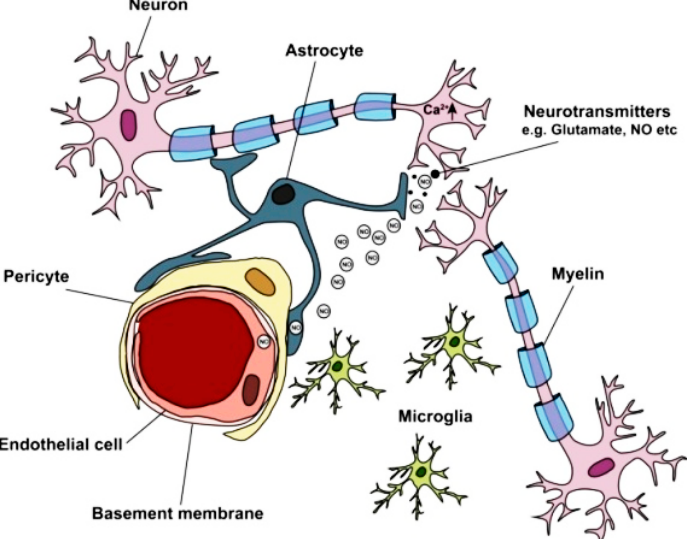
Figure 2. Diagram of the neurovascular unit (NVU). The neurovascular unit represents an interactive network of vascular cells (pericytes and endothelial cells), glia (astrocytes and microglia), and neurons. Adapted from [24].